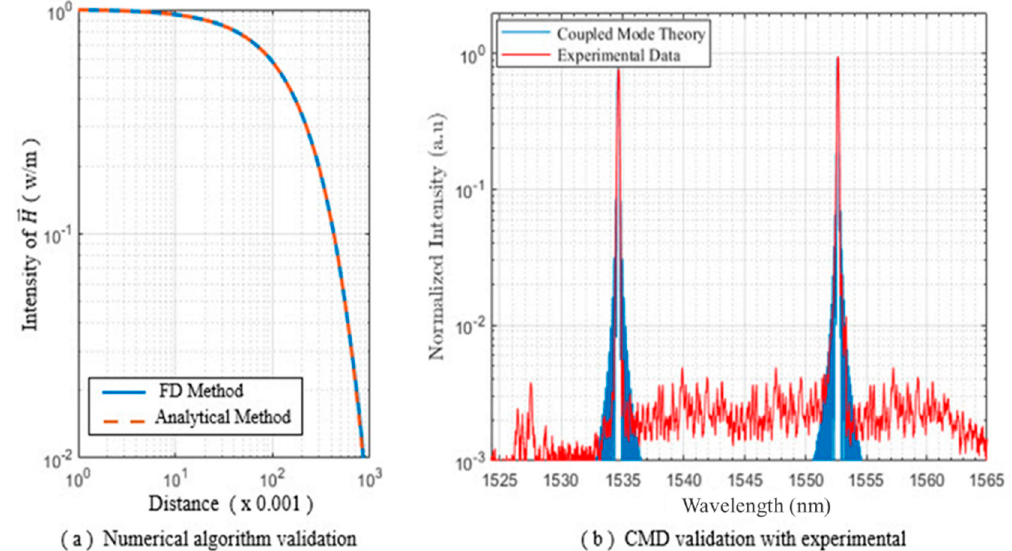
Figure 4. Numerical validation of proposed algorithms based on analytical solution and experiment data.